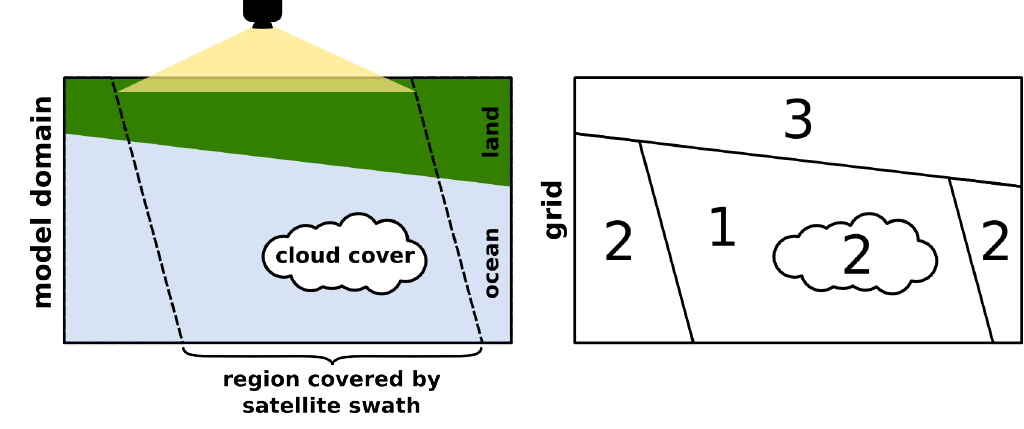
Figure 1. Schematic of a satellite taking an image (left panel) and corresponding subregions on the model grid (right panel). Subregion 1 in the right panel corresponds to X = A ∩ B , where the view of the ocean is clear. The satellite image does not cover real real real the entire model domain and clouds as well as other interferences cause missing values in ∩ B the data, creating subregion 2 ( A ). The model domain includes land, resulting in real NaN ∩ B subregion 3 ( A NaN NaN